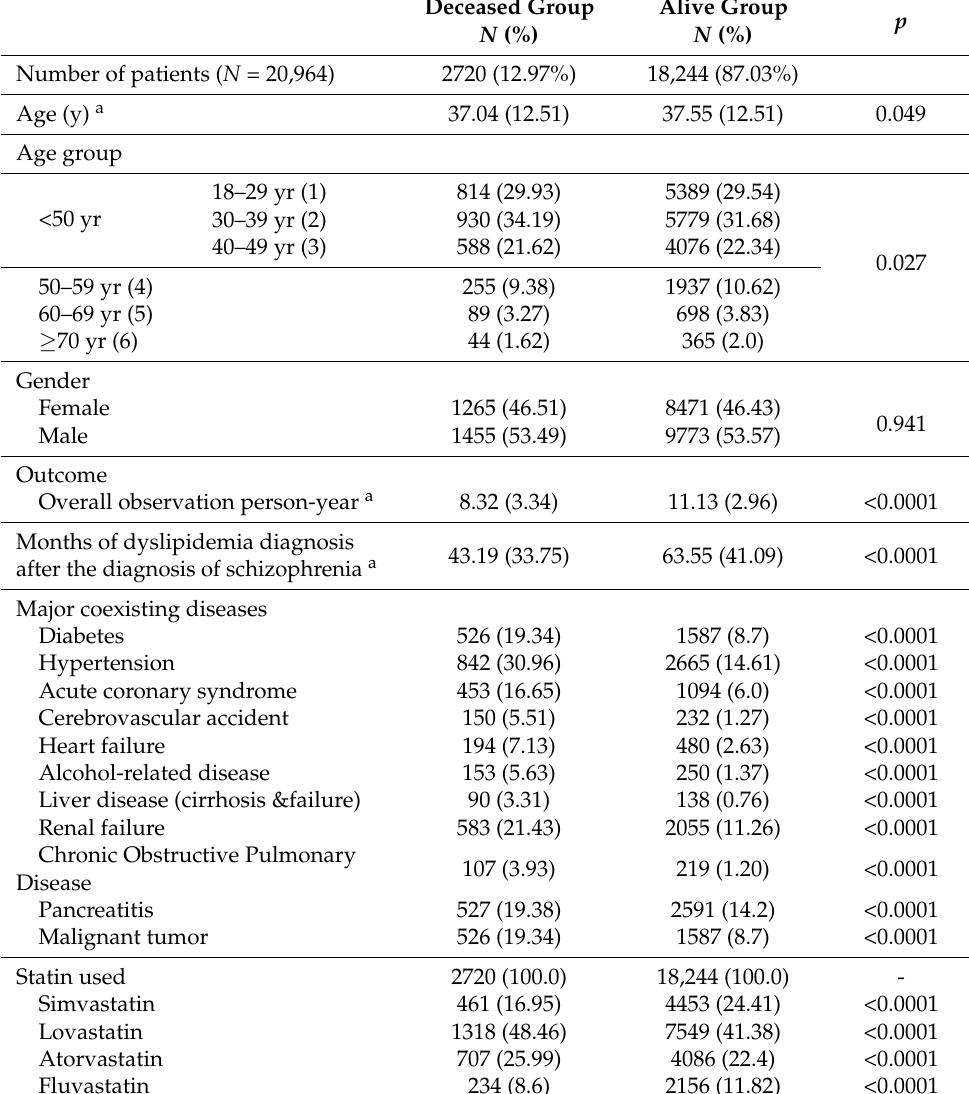
Table 1. Baseline demographics and clinical characteristics of the study